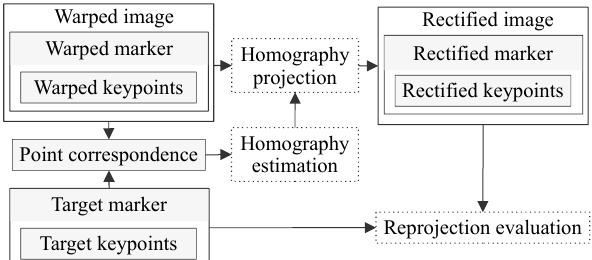
Figure 2. Visualization of relationships in our established terminology. The diagram also shows the hierarchical dependence of individual terms. Dotted elements represent processes with arrows denoting their input and